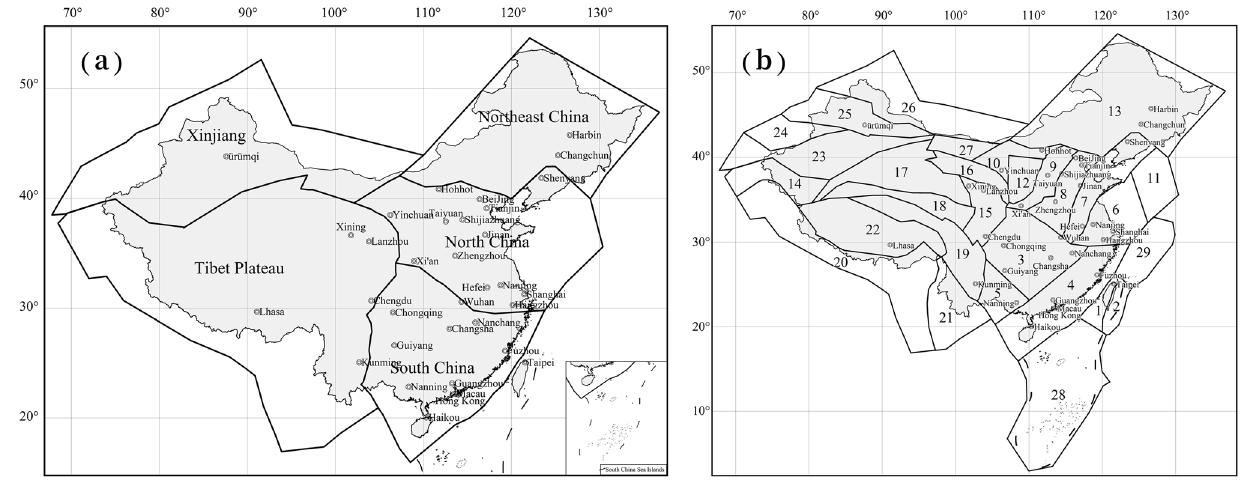
Fig. 1 a Division of seismic zones in China’s mainland. The black polygons are the seismic zones. There are five seismic zones in Chi- na’s mainland. b Distribution of seismic belts in China. Small black